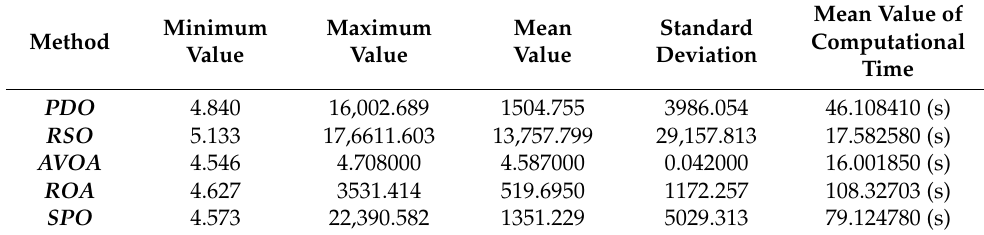
Table 14. Statistical analysis for proposed algorithms with case